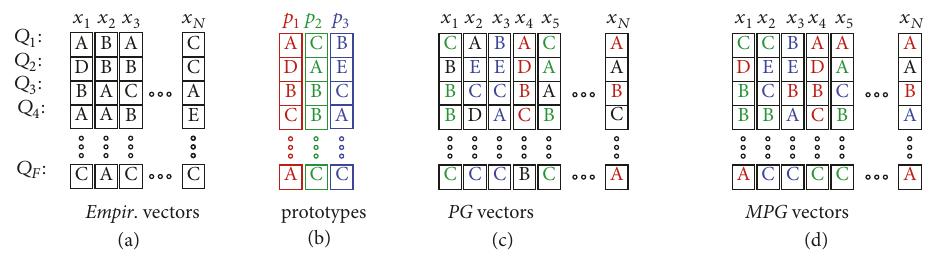
Figure 1: Schematic illustration of the two stochastic models, showing (a, b, c, and d) an empirical SCV with 𝑁 vectors ( 𝑥 1 to 𝑥 𝑁 ) and 𝐹 nominal variables ( 𝑄 𝑄 𝑘 = 3 cultural prototypes for the same 𝐹 variables; an SCV with 𝑁 vectors generated, from the 1 to 𝐹 ); a set of prototypes, using the PG model; an SCV with 𝑁 vectors generated, from the same prototypes, using the MPG model. For the PG and MPG sketches, red, green, and blue denote the copies of cultural traits from one of the first, second, and third prototype, respectively, while black denotes the explicitly random generation of